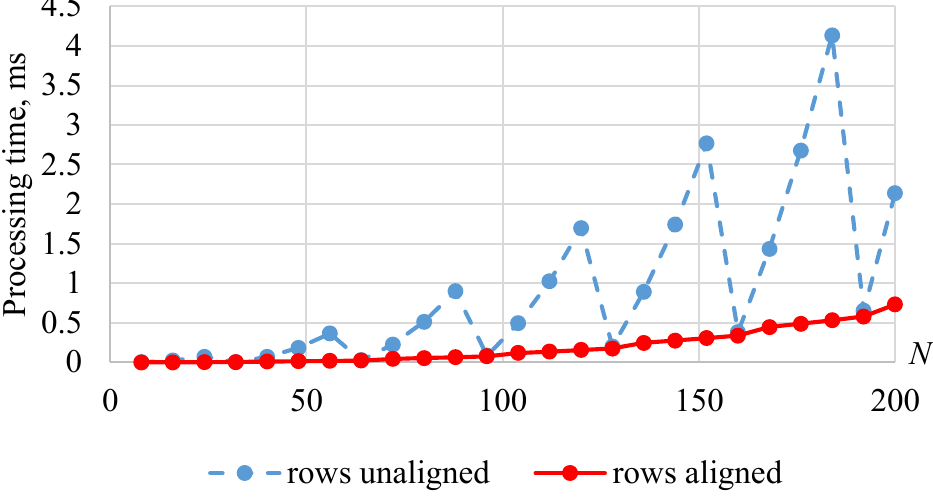
Figure 6. Processing time for matrix multiplication of 16-bit unsigned integers with and without rows alignment depending on matrix size.